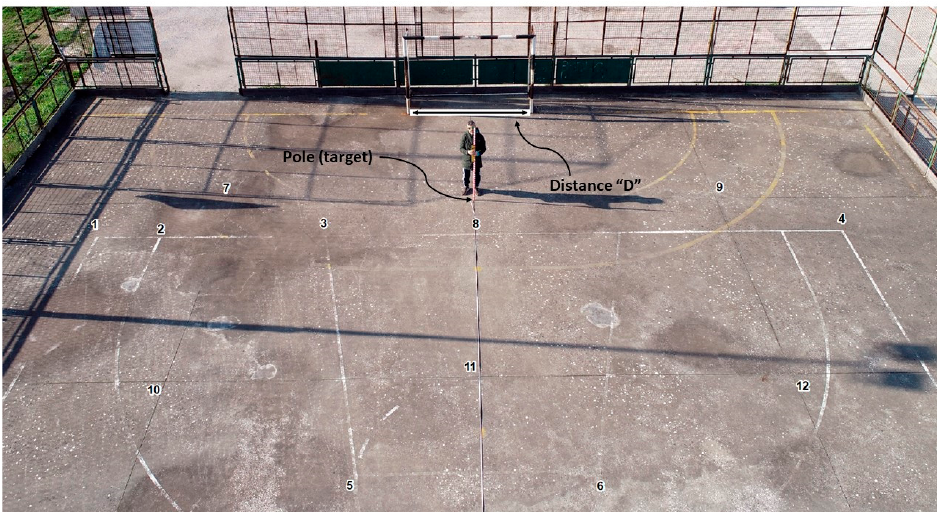
Figure 7. Example of still image (DJI126) acquired with DJI Phantom 4 PRO used for the field test 1 and 2. All the images used in the tests had as principal point located over the target (a wooden pole holds vertically from the ground). The reference distance used in the Test 1 is indicated as “D” in the picture, while the points are representing the ground lines used in the Test 2 (Source: Personal collection).